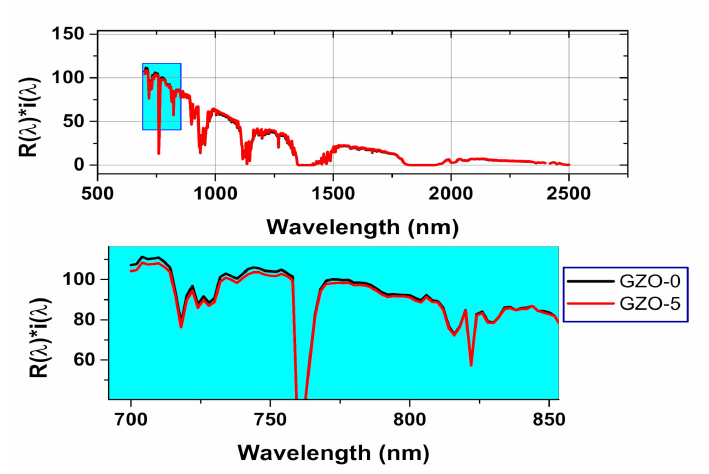
Figure 8. The e ff ective reflectance, R ( λ ) * i ( λ ) spectrum for GZO-0 and GZO-0 nanopigment samples using a real incident solar radiation according to the ASTM